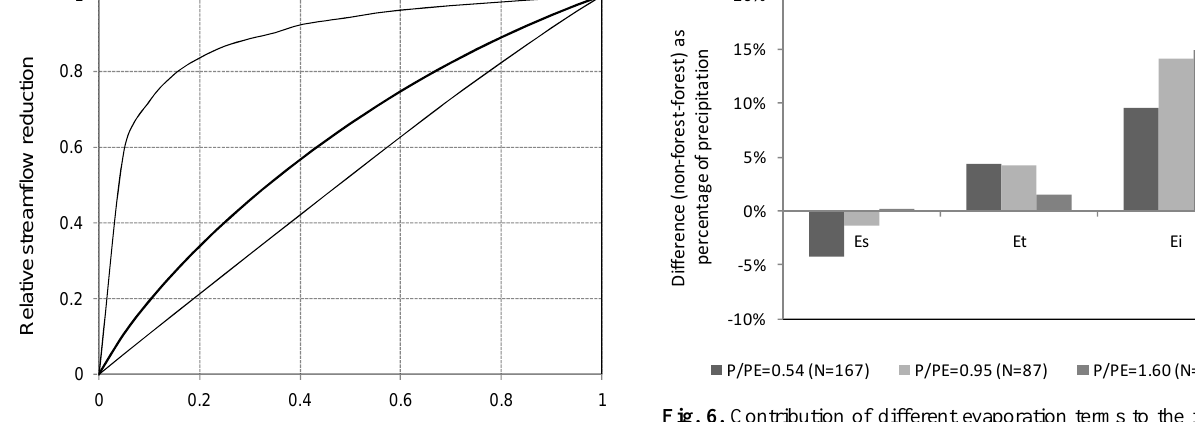
Fig. 6. Contribution of different evaporation terms to the increase of mean streamflow after forest removal estimated by the AWRA-L model, expressed as a percentage of rainfall. Values represent fluxes averaged over three groups of catchments, intended to represent (from left to right) water-limited ( P /PE < 0.75), transitional, and energy-limited ( P /PE > 1.25) environments. Es=soil and open water evaporation; Et=transpiration; Ei=rainfall interception losses.